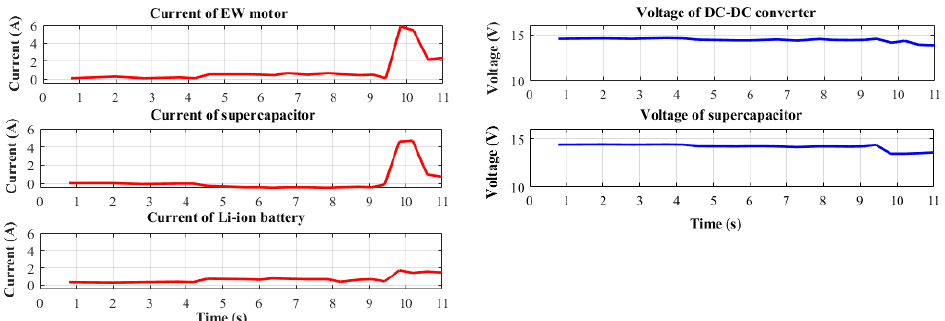
Figure 10. The experimental results at the start of the EW movement.